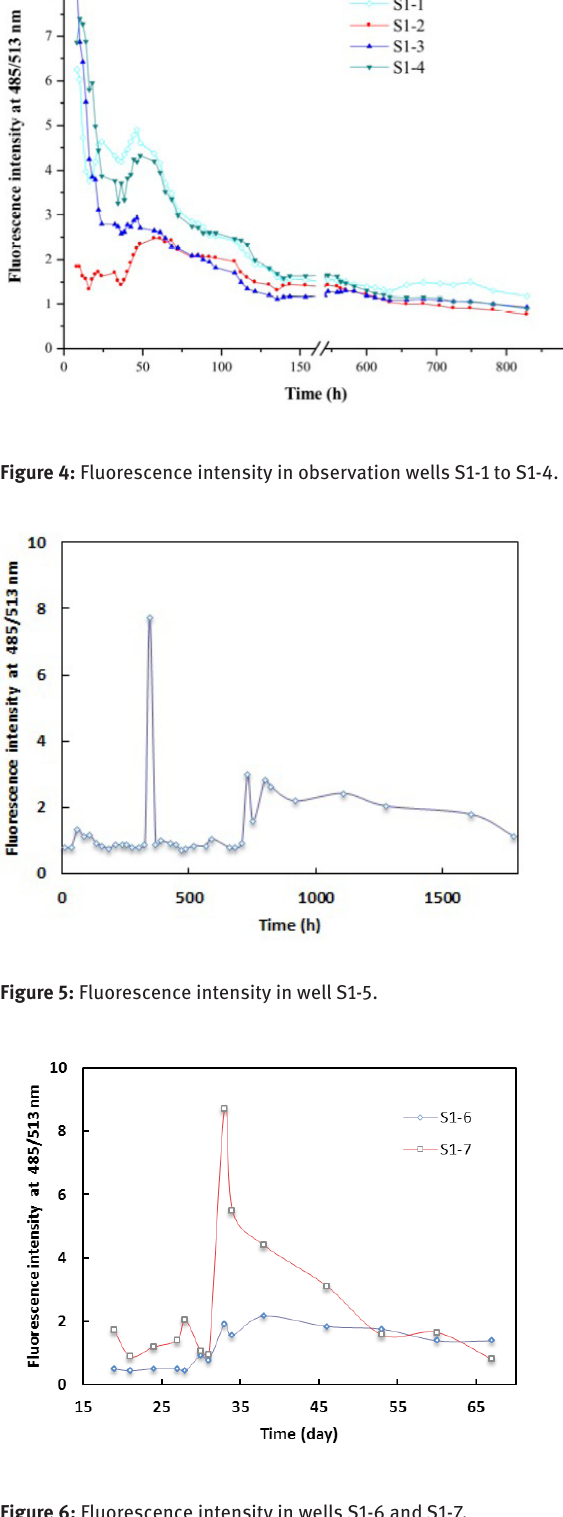
Figure 6: Fluorescence intensity in wells S1-6 and